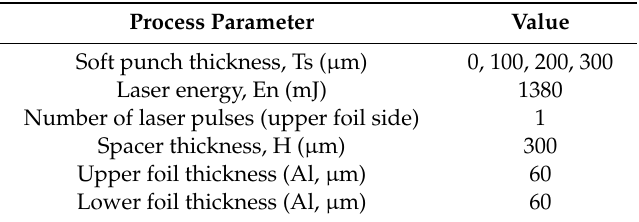
Table 3. Soft punch thickness and other experimental process parameters.